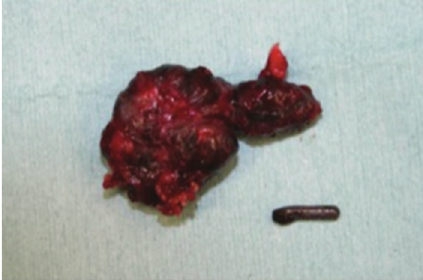
Figure 3: A black-pigmented fragment of 28 × 30 mm along with a lead was removed.